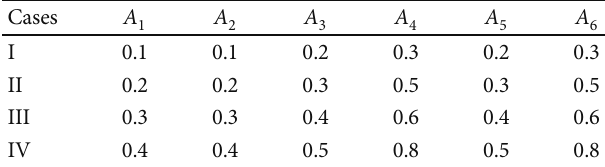
Figure 8: Concentration pro fi les for scaled stretching parameter Λ . Table 4: Four cases for values of micropolar material constants.